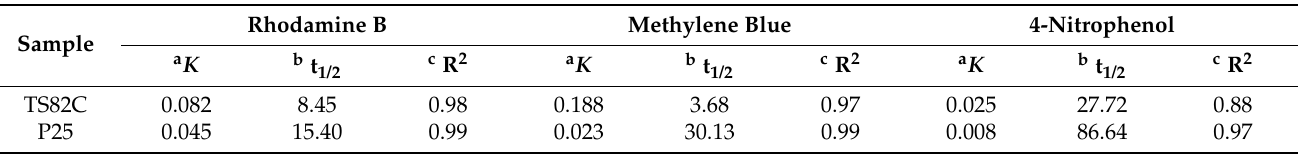
Table 3. Kinetic parameters of Rhodamine B, Methylene Blue and 4-Nitrophenol obtained from the photodegradation experiments performed with TS82C and P25 TiO 2